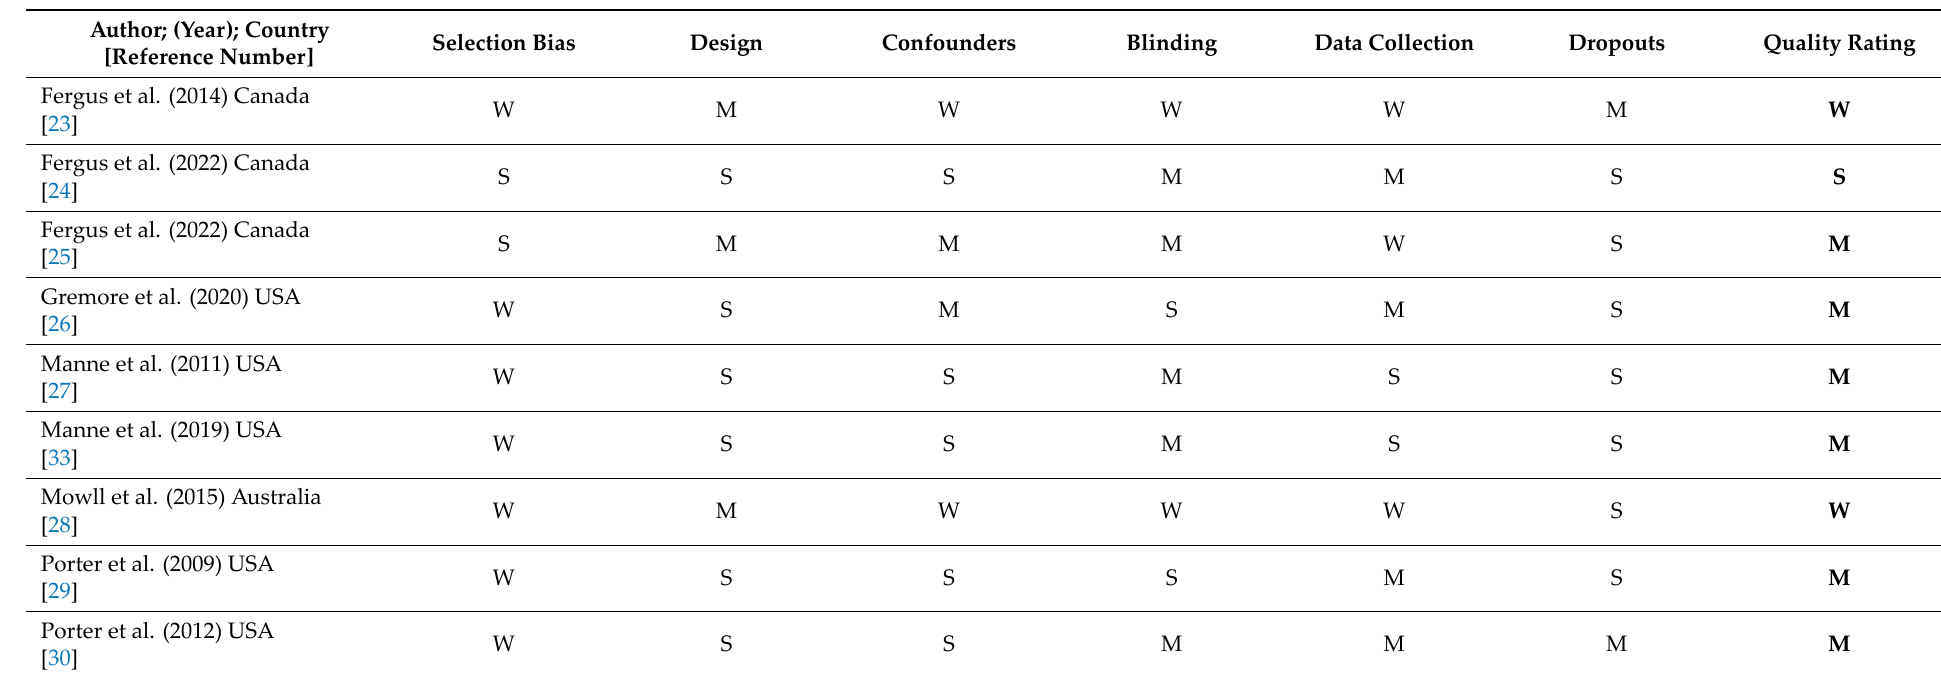
Table 3. Quality assessment of the included studies (n =